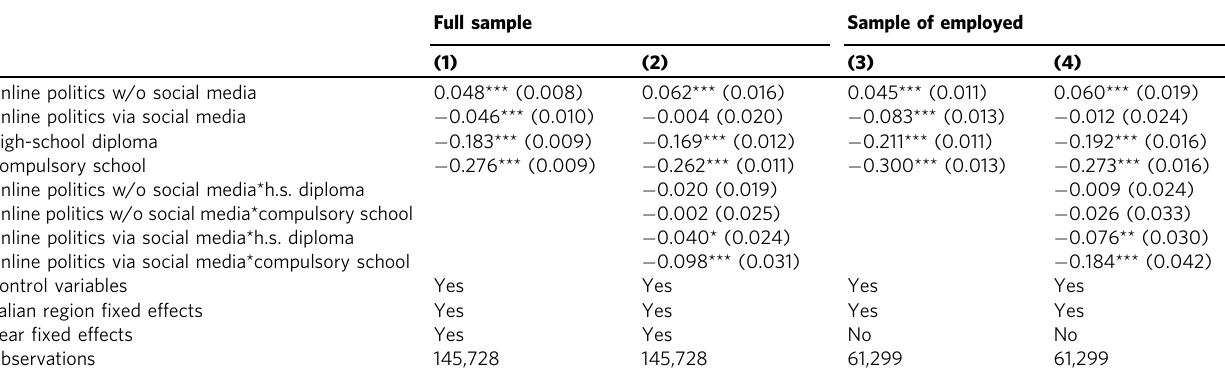
Fig. 2 Average marginal effects of online politics by years of education. Calculation from the fourth column of Table 1. The average marginal effects are plotted with the 95 percent con fi dence intervals. The dependent and control variables are described in the note to Table 1. Table 2 Ordered probit regressions of trust in European parliament on online politics interacted with the level of